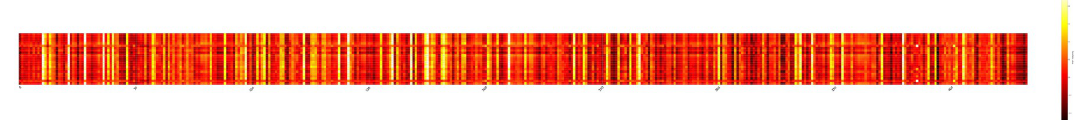
Fig 8. Correlation between toxic drugs and non-toxic drugs. Toxic drugs are in rows and non-toxic ones are in columns.